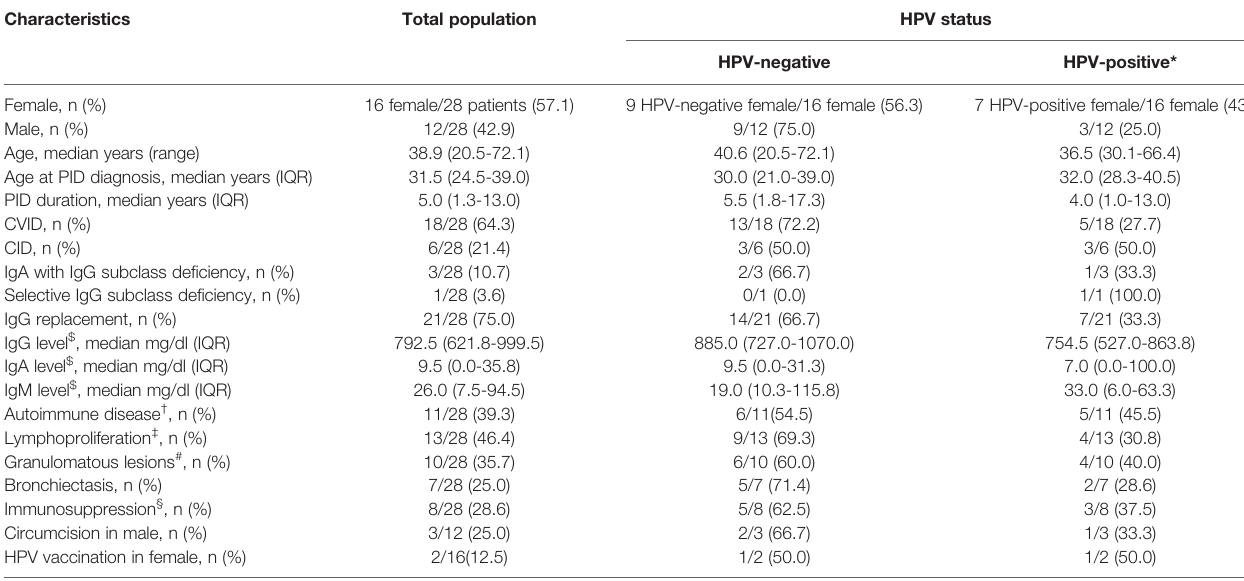
TABLE 1 | Characteristics of the study population. Characteristics